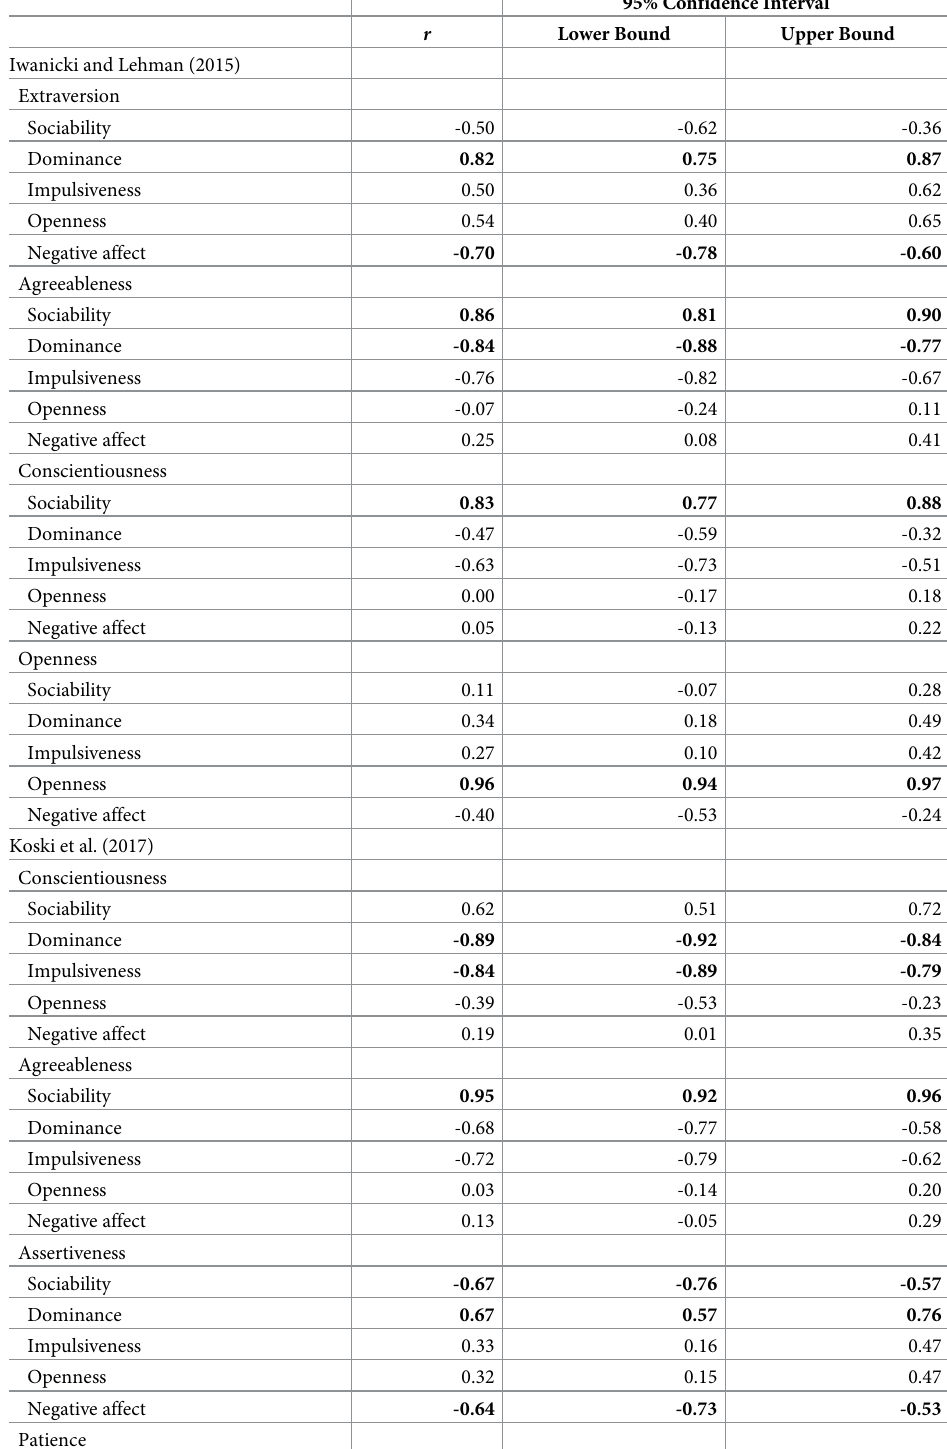
Table 6. Correlations between unit-weighted factor scores based on factor loadings in the present study and factor loadings from previous studies of common marmoset